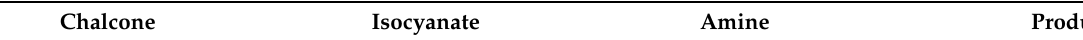
Table 1. Azidochalcone, isocyanates, and amines as starting reagents to generate the corresponding